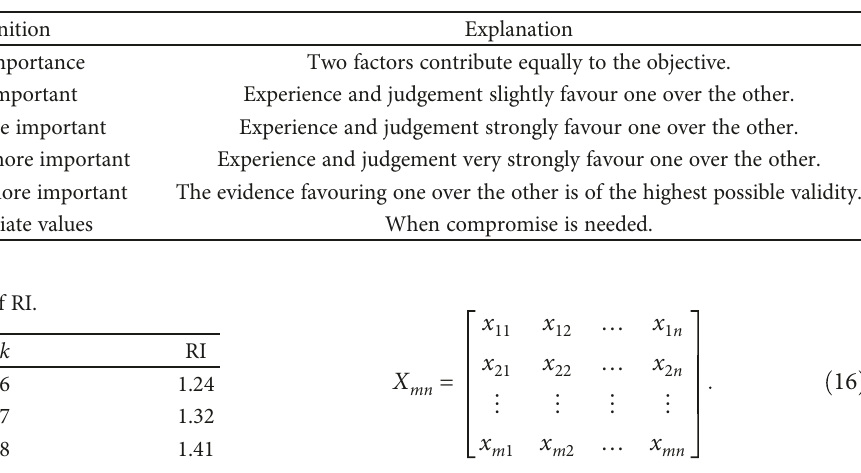
Table 1: Rating scale of AHP method.